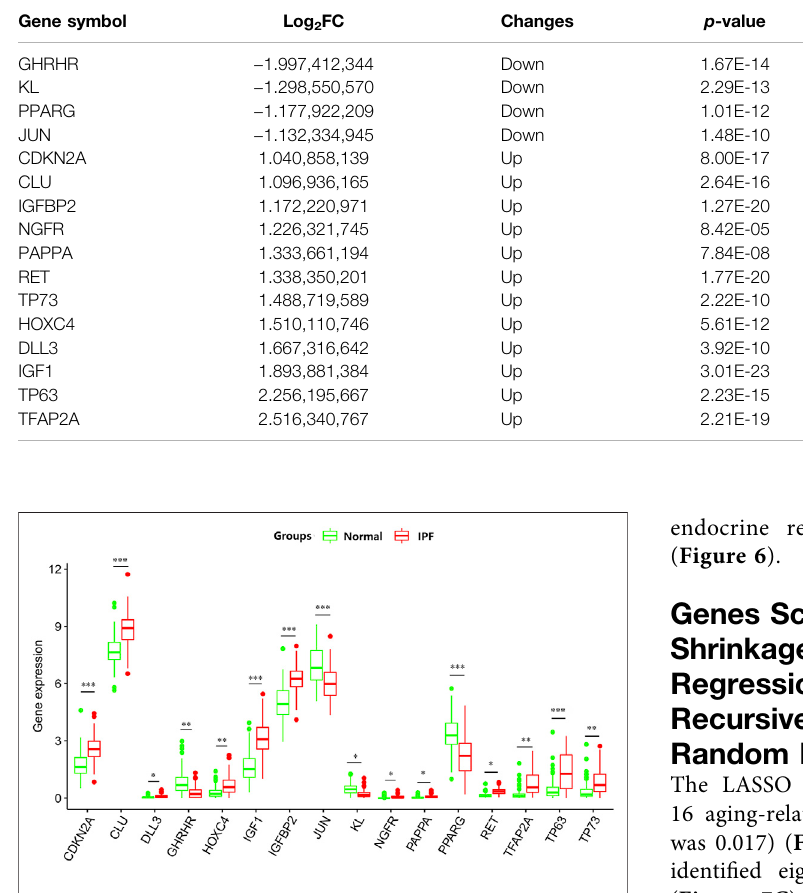
FIGURE 2 | The box plot of 16 differentially expressed aging-related genes in IPF and healthy samples.* p < 0.05; ** p < 0.01; *** p < 0.005.